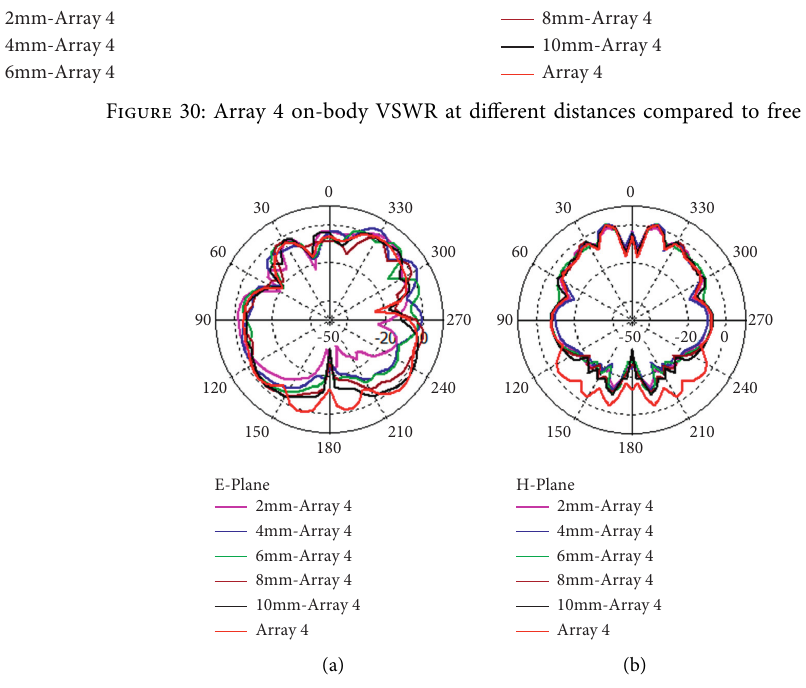
Figure 31: Array 4 on-body radiation pattern at 60GHz. (a) E-plane. (b) H-plane.